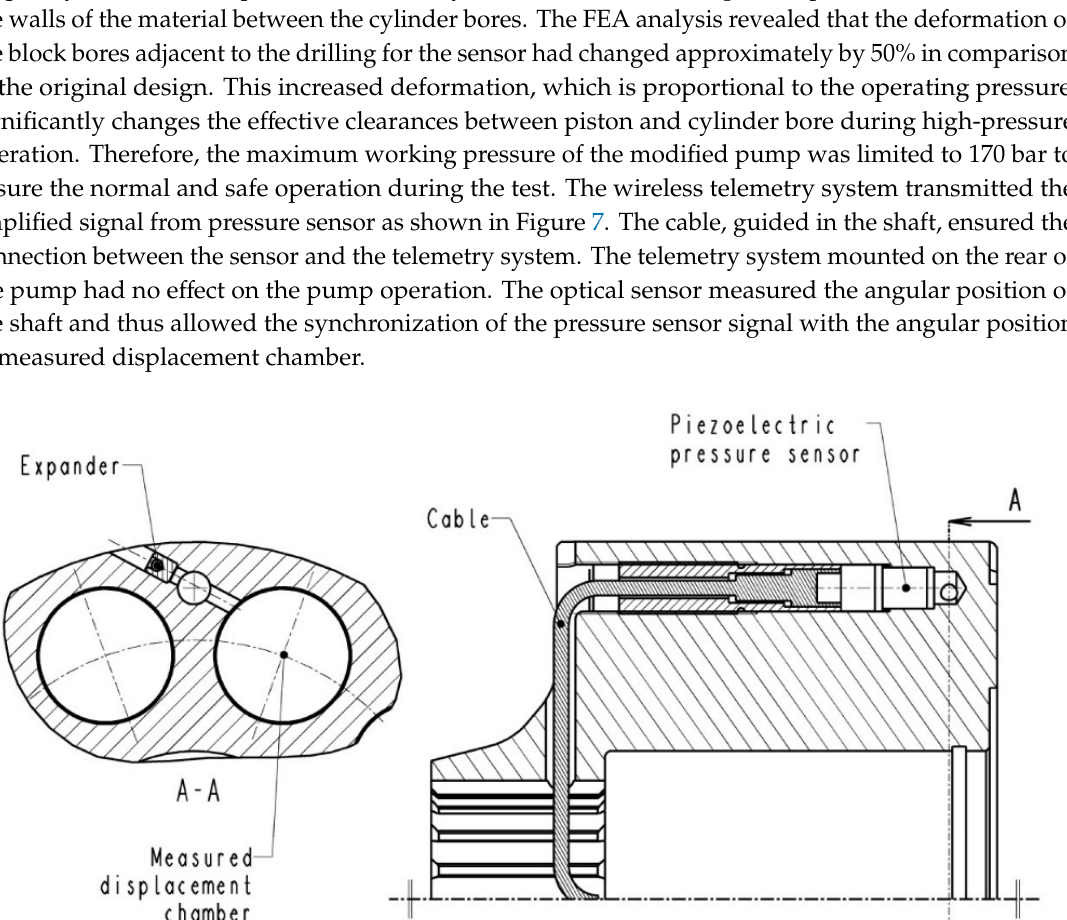
Figure 7. The principle schema of telemetry system and its installation on the pump. 4.2. Valve plate Temperature Distribution Measurement A set of thirty thermocouples placed 1 mm underneath of the sealing surface of the valve plate measured the solid body temperature distribution as shown in Figure 8. The temperature distribution in valve plate is controlled by the heat flux on its surfaces, most importantly, the sealing surface. The energy dissipation in the fluid film determines the heat flux on the valve plate-sealing surface, which is subsequently transformed into heat energy and into the thermal field of the valve plate respectively. The energy dissipation in the fluid film is highly dependent on the fluid film thickness; therefore, the temperature of the valve plate is an indicator of the thickness of the fluid film. Figure 9 shows the subassembly of the valve plate in the housing of modified pump with the thermocouples, which have a way out from the pump as depicted in Figure 7.